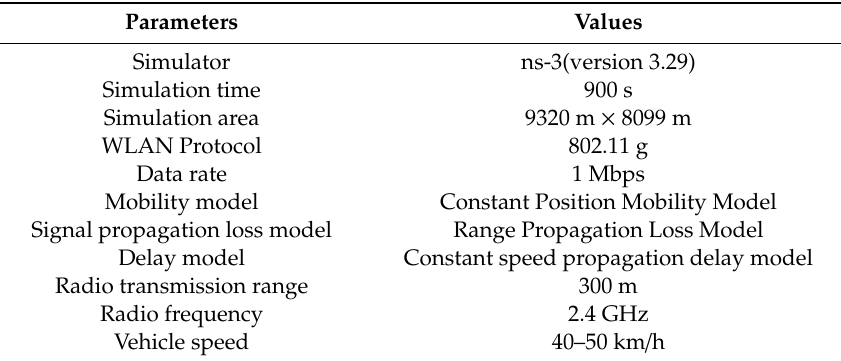
Table 3. Parameters setting for ns-3.